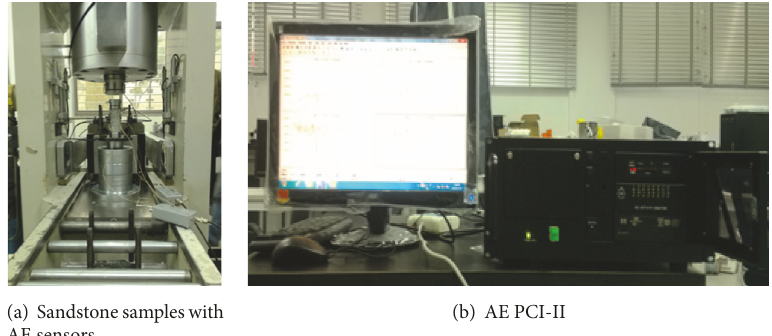
Figure 2: Sandstone samples in MTS 815 servo-controlled rock mechanics experimental system and AE PCI-II